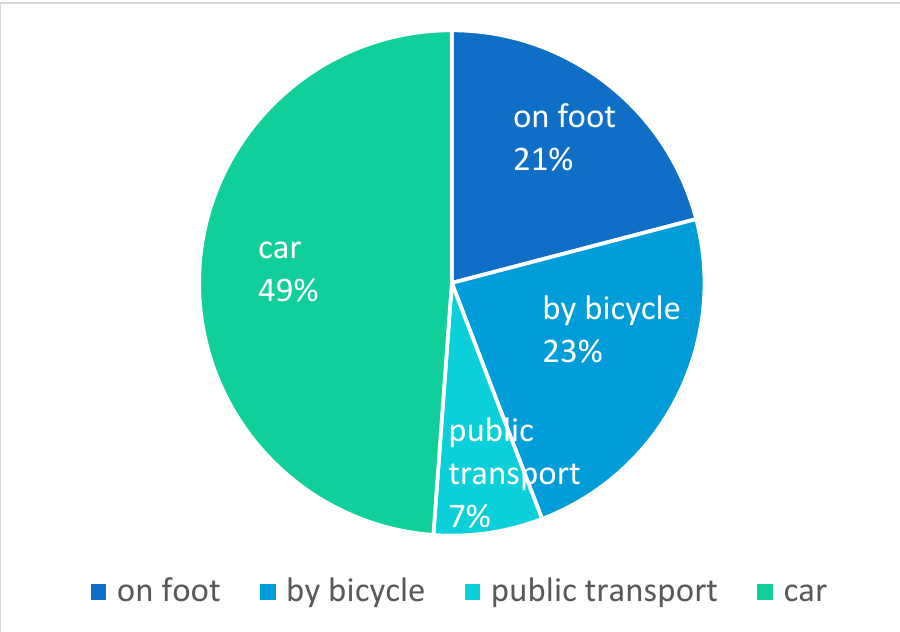
Figure 3. Means of transportation / modal split. Some tenants of coworking spaces are traveling around and visit different coworking